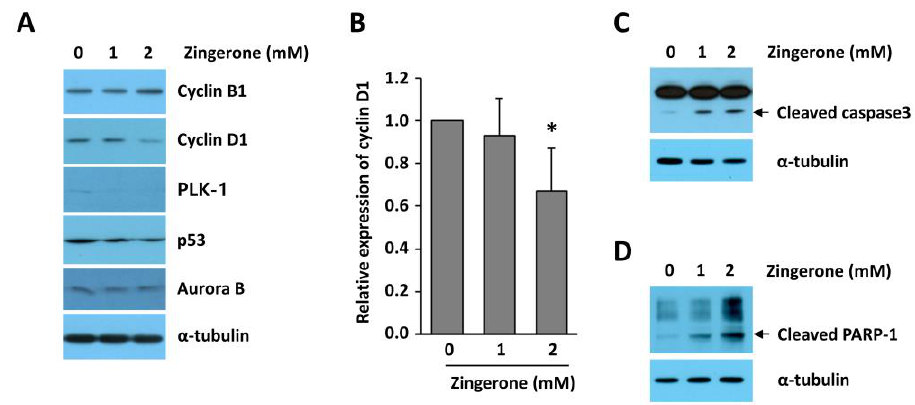
Figure 4. Effect of zingerone on the expressions of cell-cycle-associated proteins and apoptosis in BE(2)-M17 cells. ( A ) BE(2)-M17 cells were treated with the indicated concentration of zingerone for 24 h. Cell lysates were chemiluminescent-immunoblotted with antibodies for cyclin B1, cyclin D1, polo-like kinase 1 (PLK-1), p53, and Aurora B. ( B ) The relative cyclin D1 levels (cyclin D1 expression vs. α -tubulin expression) from three independent experiments were expressed as means ± SD of the mean. The expression in the control was set to 1.0. * p < 0.05 vs. vehicle-treated control. ( C , D ) BE(2)-M17 cells were treated with the indicated concentration of zingerone for 72 h ( C ) and 96 h ( D ). Cell lysates were immunoblotted with antibodies for caspase-3 ( C ) and poly (ADP-ribose) polymerase 1 (PARP-1; D ). α -Tubulin was used as a loading control.